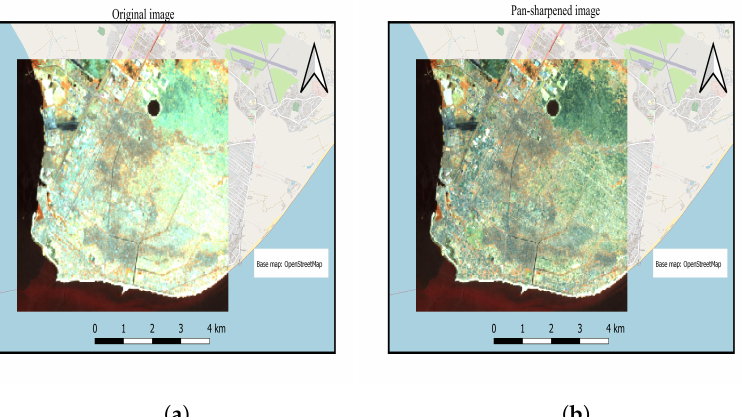
Figure 8. ( a ) displays an RGB image comprising the S2 bands 8A, 11, and 12. ( b ) shows the corre- sponding pan-sharpening results. ( a ) RGB images with the bands 8A, 11 and 12 before pan sharpening. ( b ) RGB images after pan-sharpening.